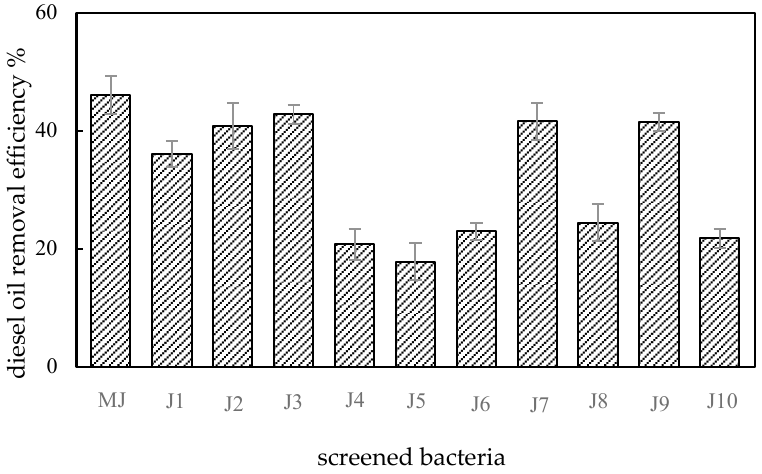
Figure 1. The removal efficiency rates for diesel oil using the screened bacterial strains after incubation: ( CK ) no bacteria; ( MJ ) mixed bacteria; ( J1 ) Brevundimonas diminuta ; ( J2 , J3 ) Brevundimonas olei ; ( J4 ) Brevundimonas naejangsanensis ; ( J5 ) Brevundimonas nasdae ; ( J6 ) Brevundimonas naejangsanensis ; ( J7 , J8 ) Staphylococcus saprophyticus ; ( J9 , J10 ) Acinetobacter johnsonii .